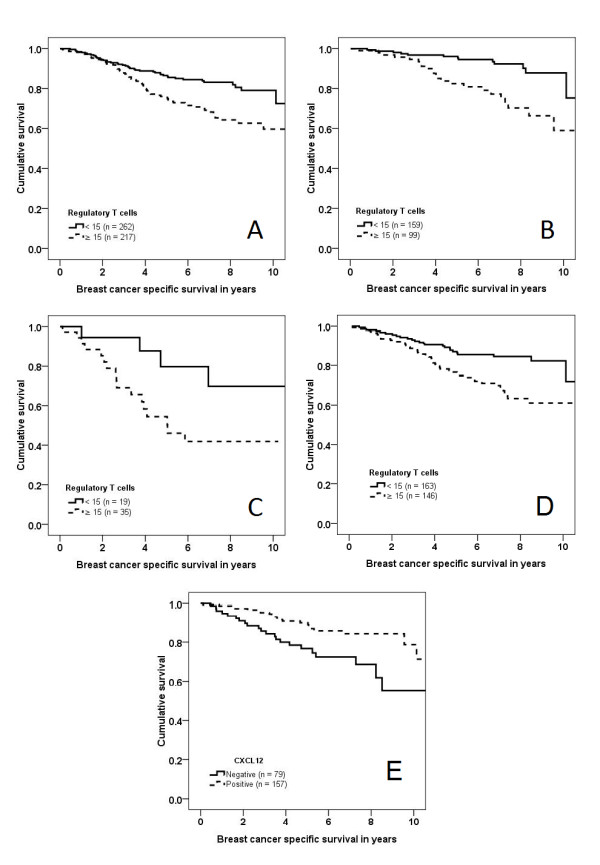
Kaplan Meier curves, breast cancer specific survival. Kaplan Meier curves, breast cancer specific survival, (A) all cancers stratified by Treg infiltration (n = 479, P = 0.001), (B) luminal cancers stratified by Treg infiltration (n = 258, P < 0.001), (C) basal-like cancers stratified by Treg infiltration (n = 54, P = 0.040), (D) patients treated with hormone therapy (n = 309, P = 0.001), (E) all cancers stratified by CXCL12 expression (n = 236, P = 0.005),